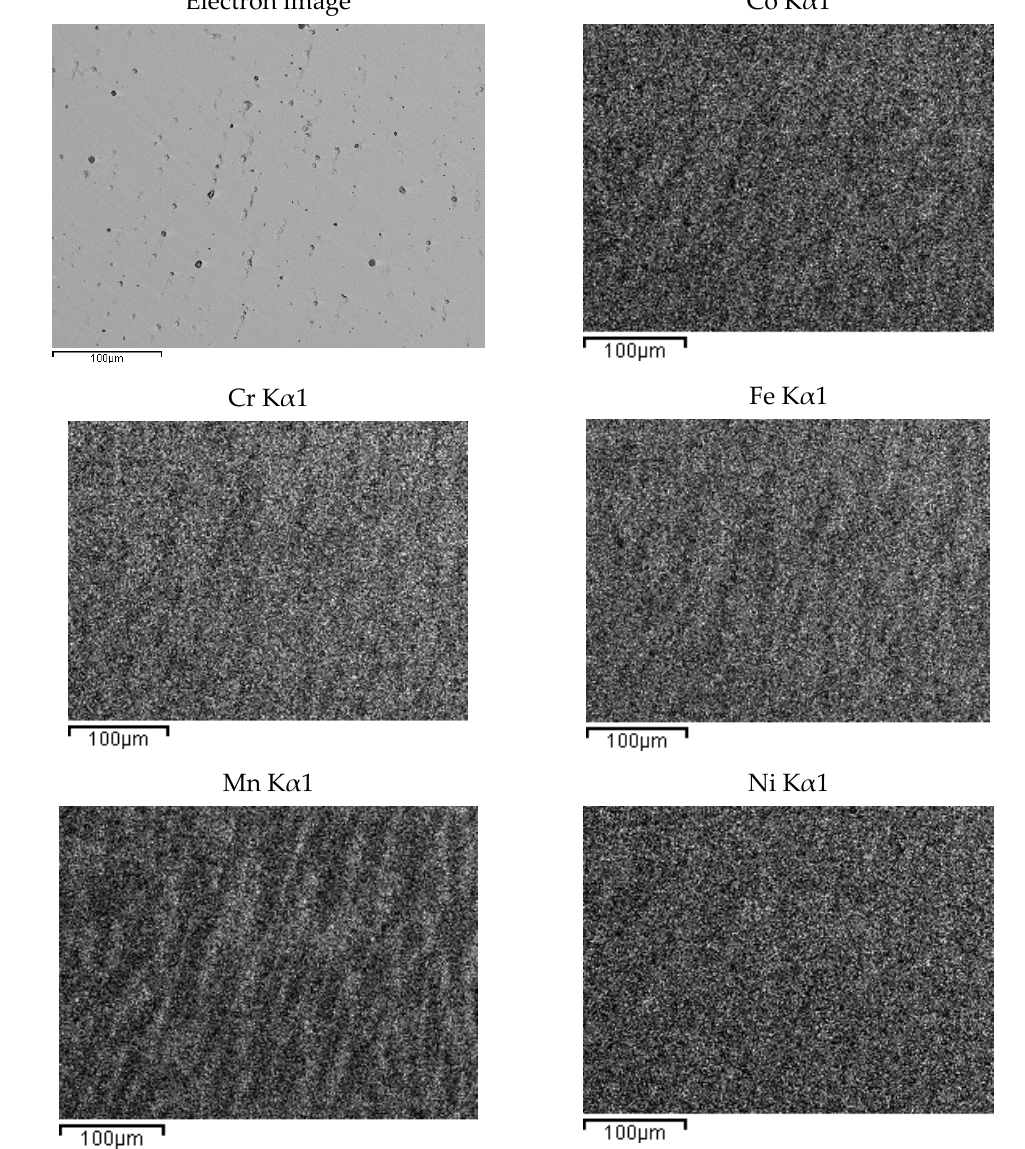
Figure 4. EDS mapping of as-cast Co 20 Cr 20 Ni 20 Fe 20 Mn 20 . The maps report, from left to right and top to bottom, the electron image of a portion of the specimen and the corresponding elemental distribution of Co, Cr, Fe, Mn, Ni. K α 1 transition was used for all elements.